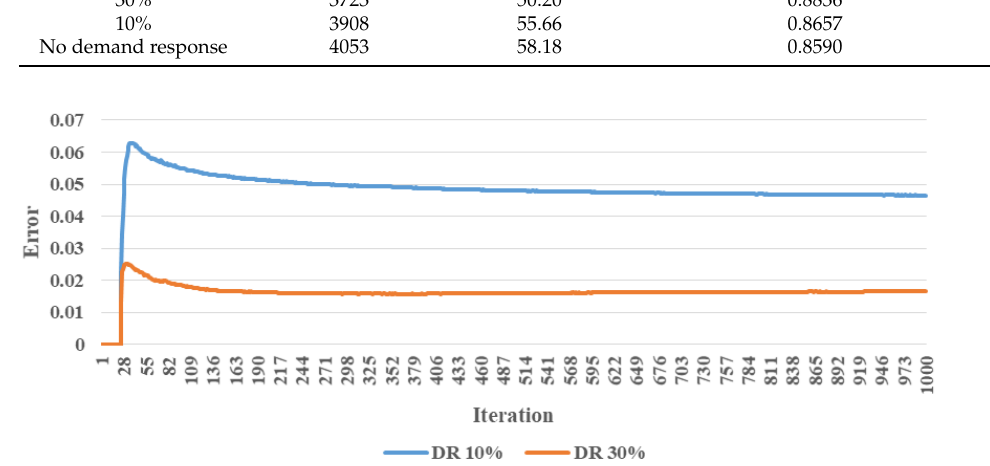
Figure 12. MVLR method